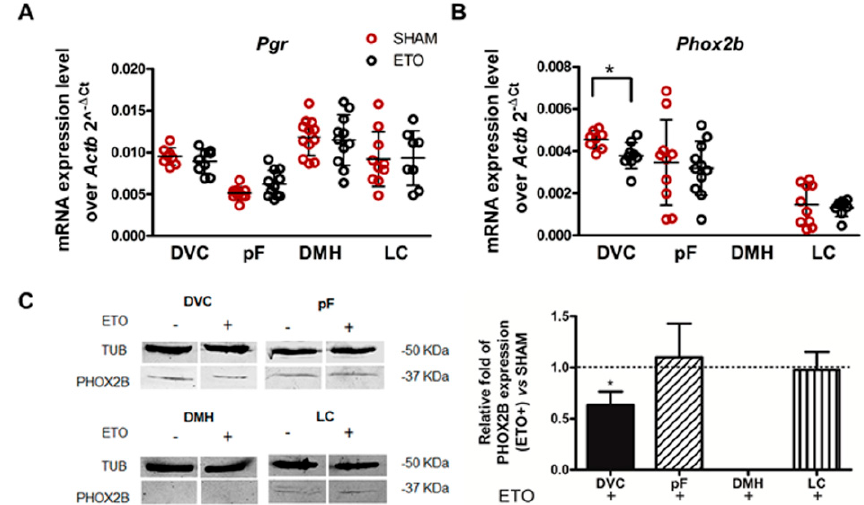
Figure 1. ETO reduces Phox2b mRNA and PHOX2B protein expression within DVC. ( A , B ) qPCR analysis of Pgr and Phox2b mRNA expression normalised to the endogenous standard Actb in naïve rats after 4 weeks ETO (black empty dots)/SHAM (red empty dots) treatment in DVC, pF, DMH and LC brain regions. Data are expressed as 2 − ∆ Ct and each data point represents one rat to show between-sample variability: black horizontal lines correspond to the mean. ( C ) Representative Western blot analysis and quantification of the effect of ETO on PHOX2B protein expression in the same area. Left: 80 µ g of protein extract from brain tissues from SHAM (ETO-) or treated (ETO+) rats, were size fractionated by means of SDS-PAGE and transferred to a nitrocellulose membrane and labelled for β -tubulin (TUB) and PHOX2B. Right: relative quantification of PHOX2B protein in ETO-treated rats. Results are reported as mean values ( ± SD) normalised to that of TUB in at least three independent experiments and are expressed as fold expression over SHAM rats (=1). * p < 0.05, Significant difference between SHAM and ETO-treated rats were assessed by Student’s t -test in each examined area.